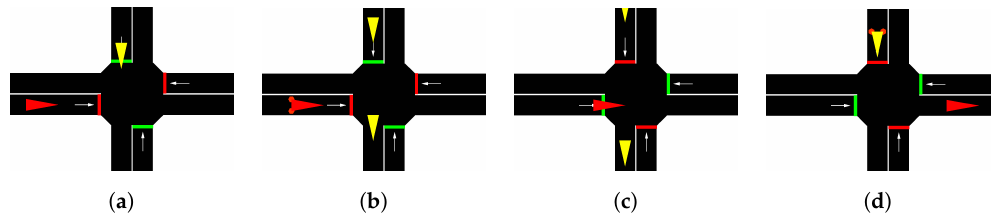
Figure 8. RL agent (red) at the intersection with the traffic light. Velocity (v), action (a) and time (t) are described for each frame. ( a ) v = 5; a = drive; t = 9.5 ( b ) v = 0; a = stop; t = 13.7 ( c ) v = 2; a = drive; t = 16.2 ( d ) v = 5; a = drive; t = 22.5.